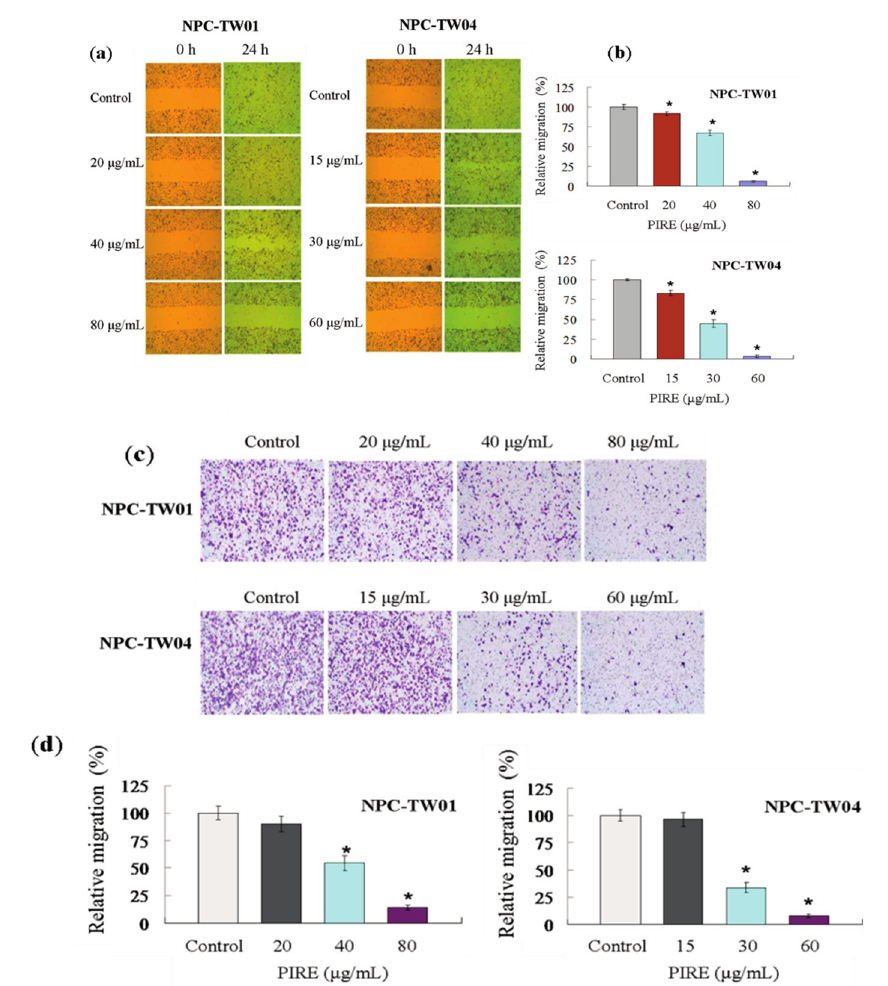
Figure 3. Effects of PIRE on NPC cell migration. ( a ) Images of wound of NPC-TW 01 and NPC-TW 04 cells treated with various concentration of PIRE at 0 and 24 h; ( b ) The